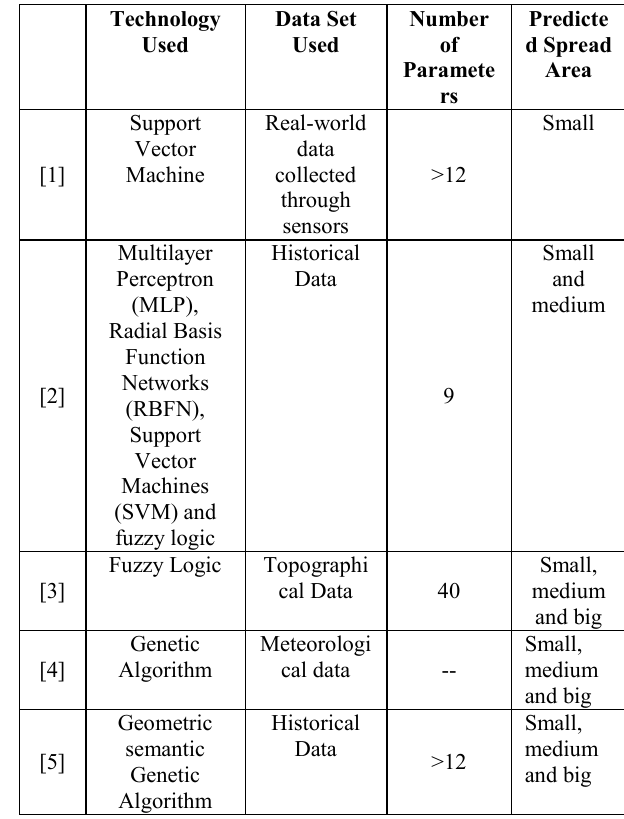
Table 2. Parameters affecting the forest